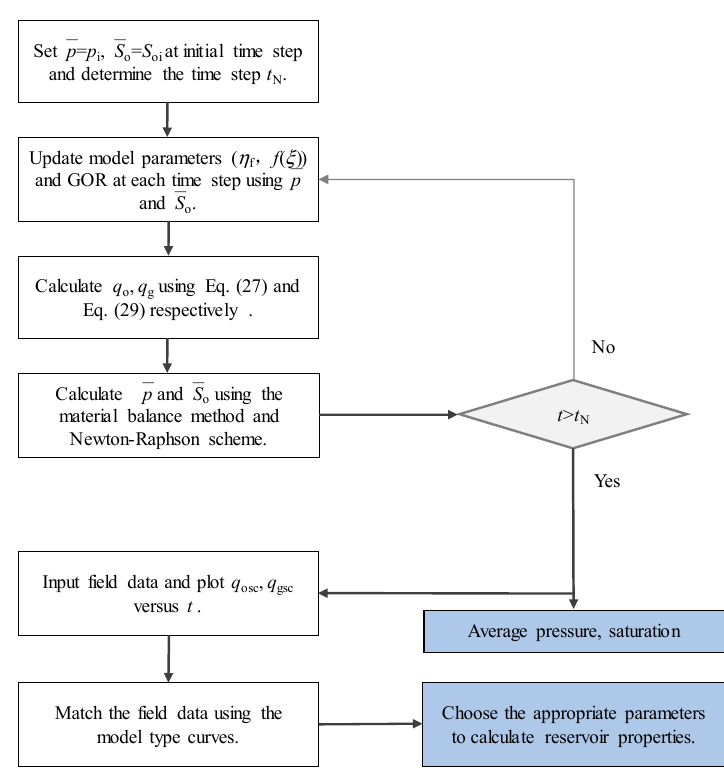
Figure 2. Flowchart of history matching procedure using the proposed semi-analytical method.